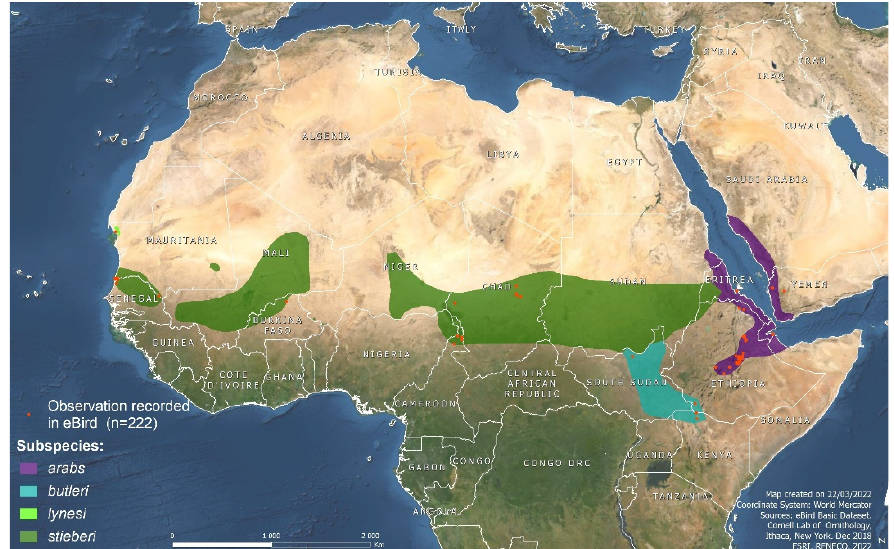
Figure 1. Distribution of Arabian bustards ( Ardeotis arabs ) subspecies. Red dots are observation events as recorded in eBird [19].